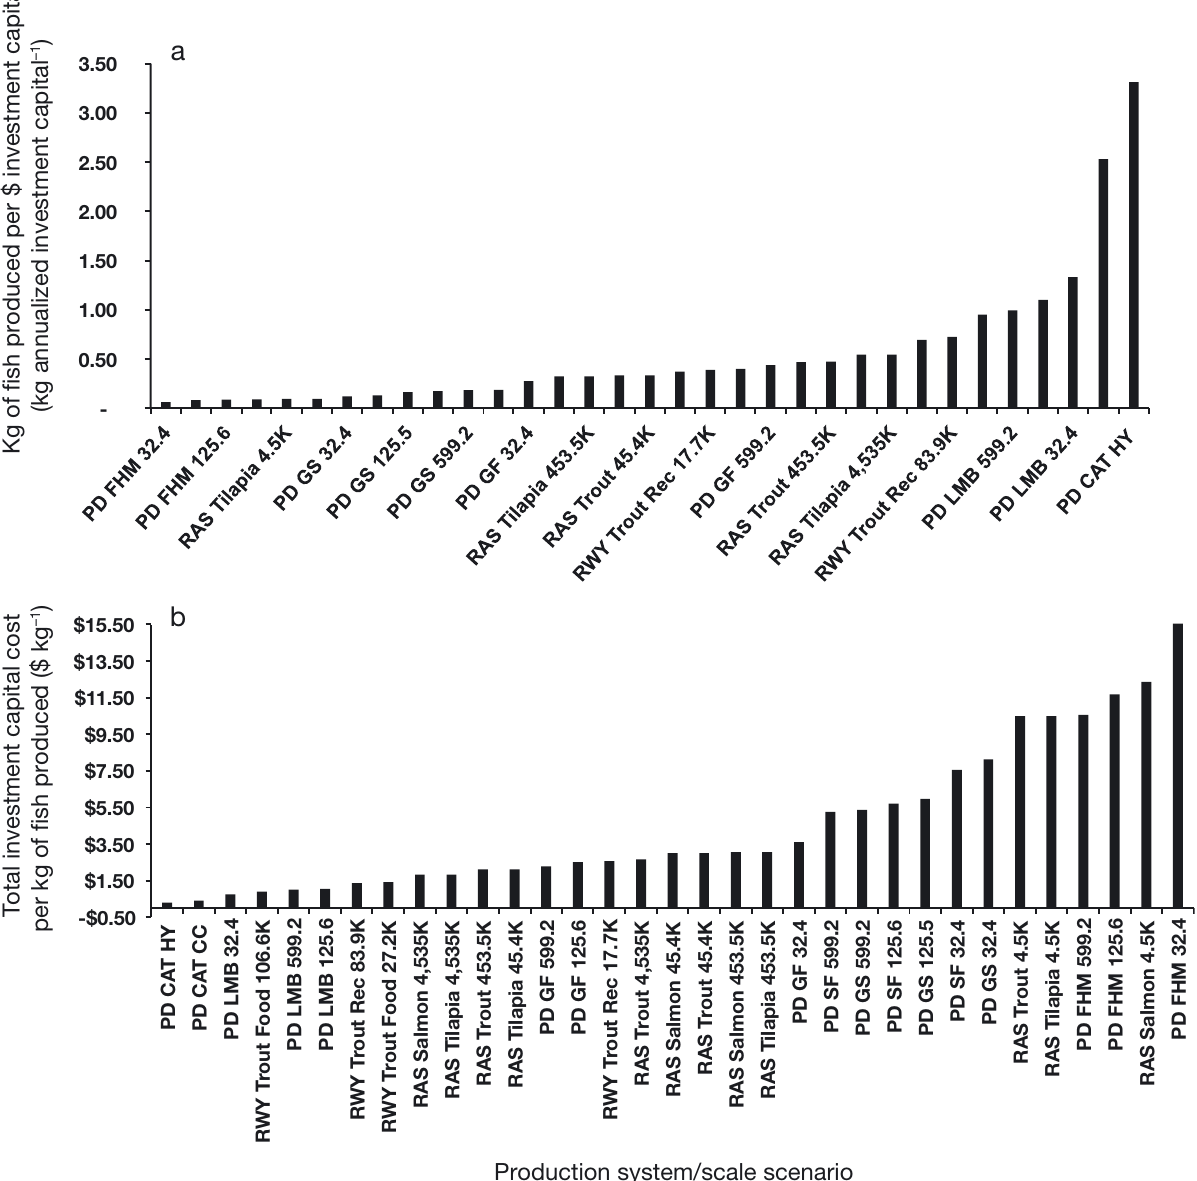
Fig. 7. (a) Investment capital and (b) investment capital cost efficiency across production systems. Abbreviations as in Figs. 1 &